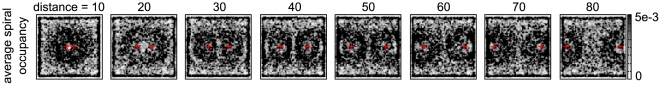
Temporal average of the spiral occupancy (disregarding handedness) for a pair of 3×3 pacemaker clusters (red +) in varying distances.Averages are over 500 minutes and 400 runs for each configuration. The cell positions on the developmental path were randomized in each run, except for the manually placed pacemaker clusters. The pattern revealed in these pictures cannot be extrapolated from single-run information as in Figures 4 and 5 (although the latter hints at it); it fully emerges only after an ensemble average is considered.